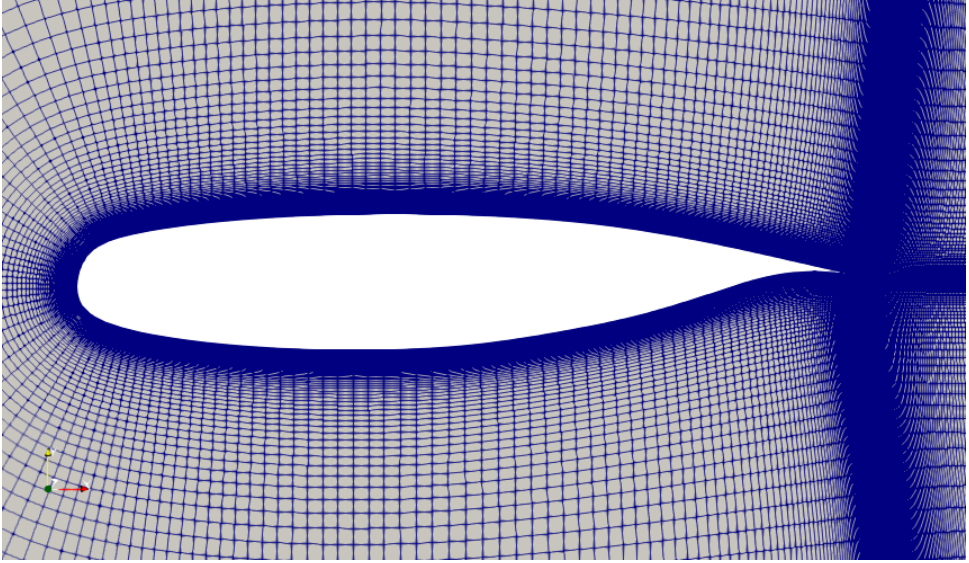
Figure 8. Mesh around the NLR 7301 baseline airfoil.